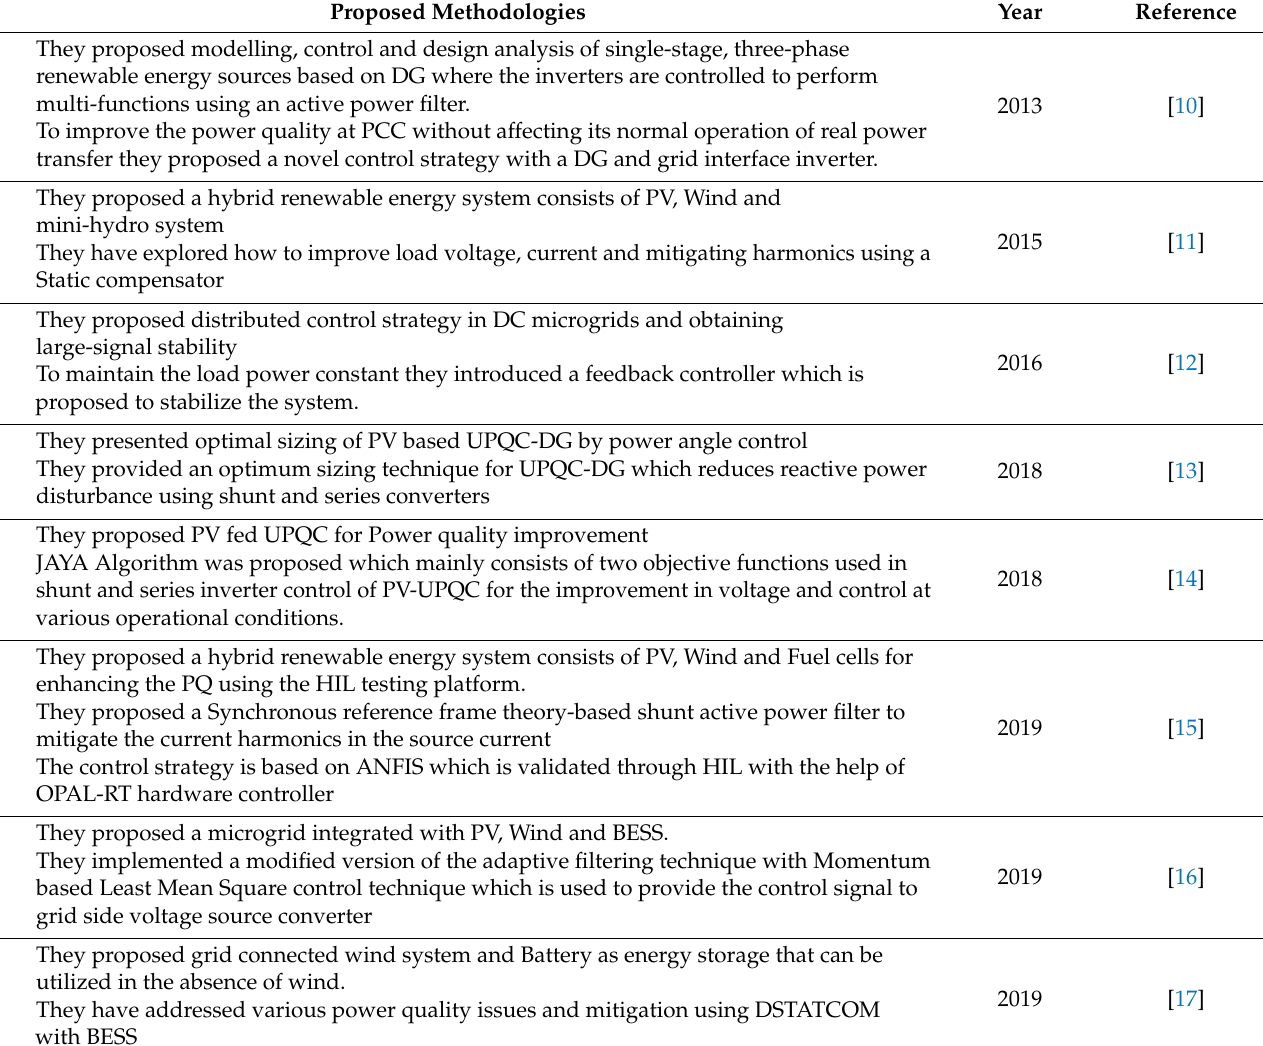
Table 1. Brief review of previously published